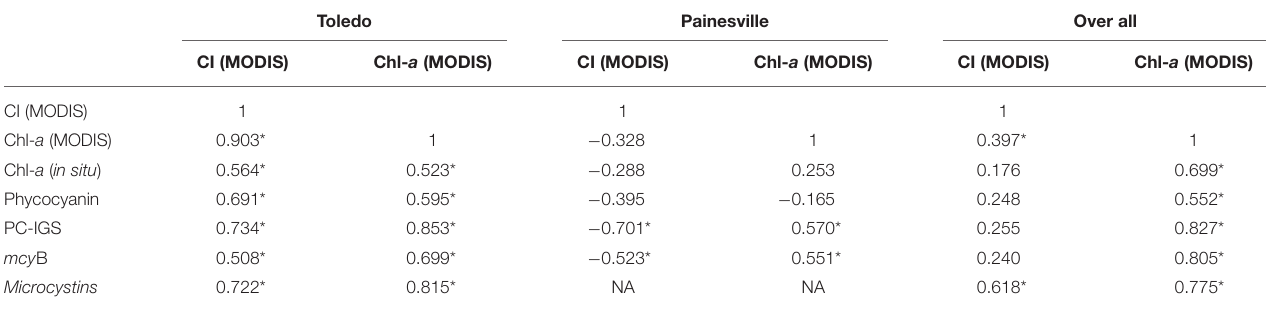
* indicates significant with P < 0.05.